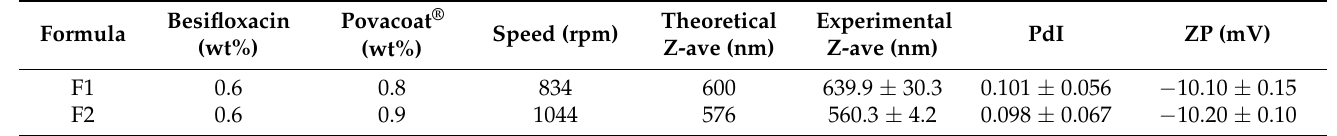
Table 5. Variables obtained in the Box–Behnken experimental design for the optimized nanocrystal preparations and respective theoretical and experimental Z-ave